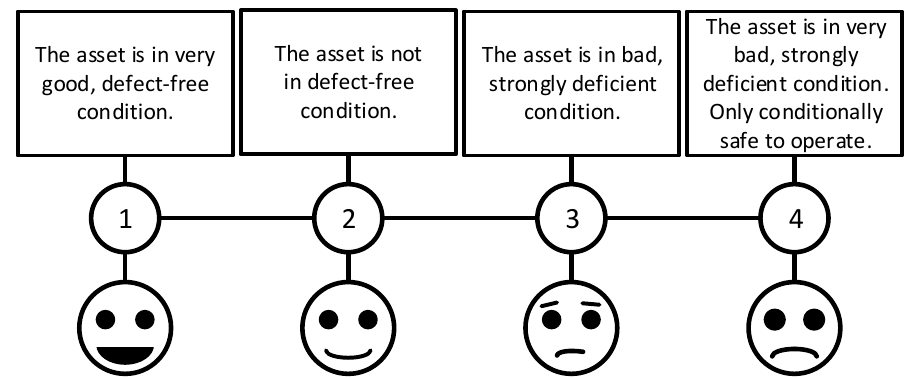
Figure 4. Simple four-stage rating scale for the assessment of substation conditions. Remark: The internal understanding at enercity Netz is that “not defect-free” is synonymous with sufficient asset condition and therefore seen as